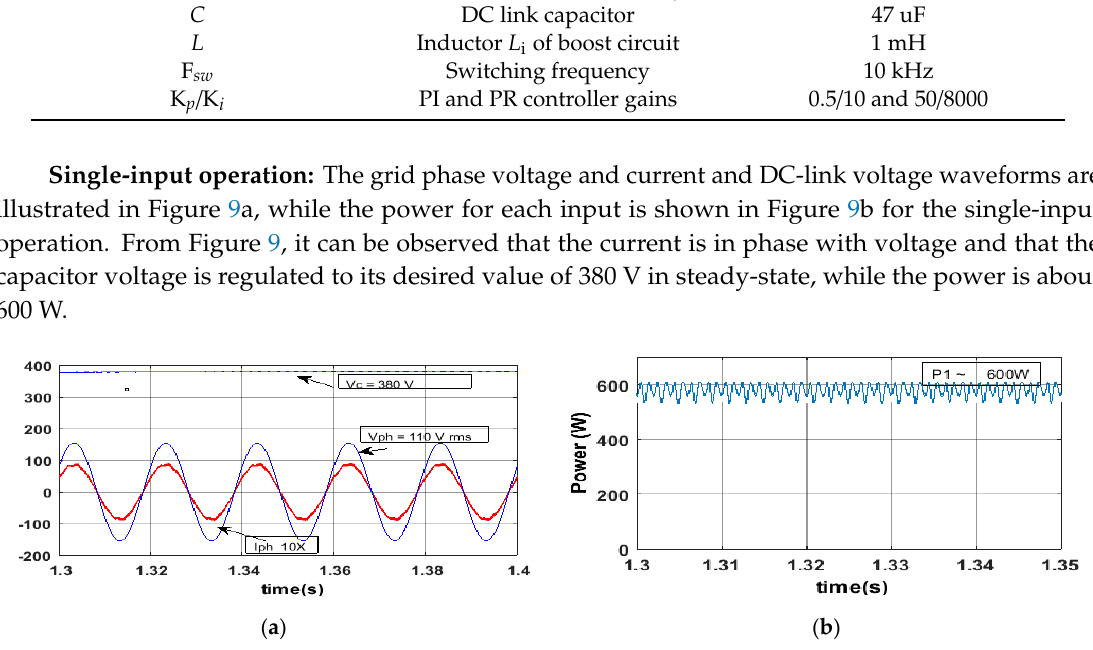
Table 2. Simulation Parameter.